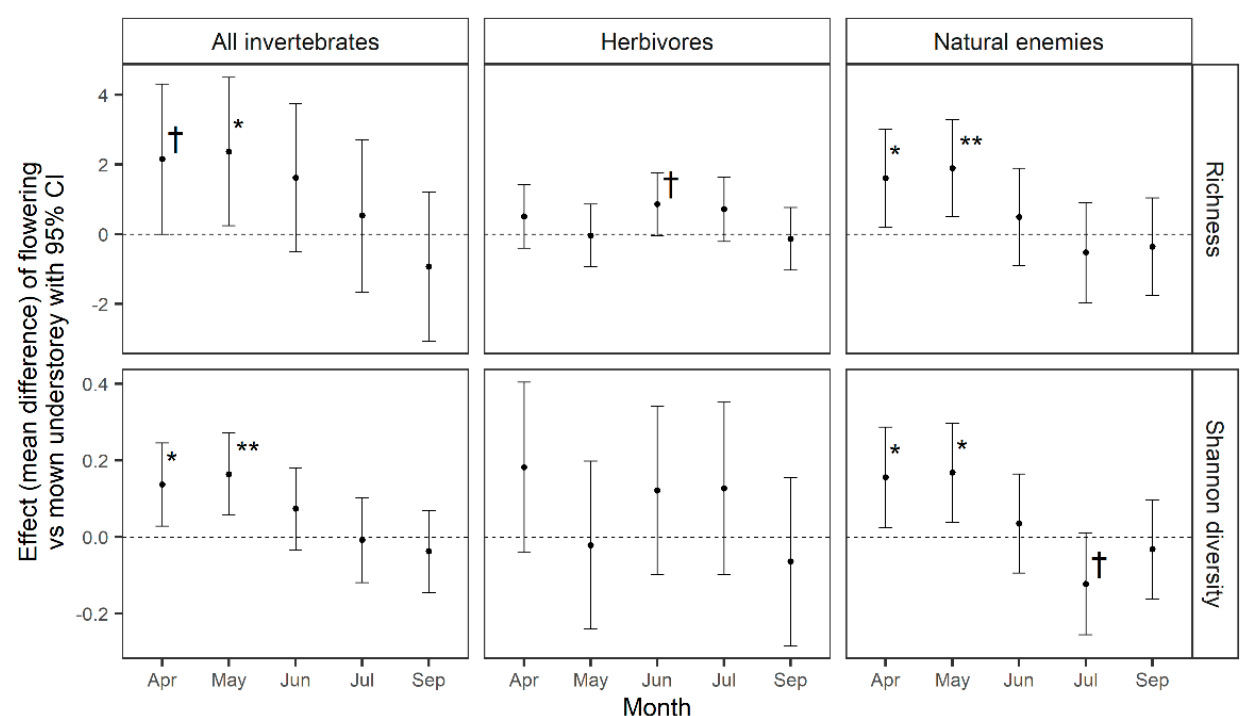
Figure 5. Effects of understorey management on invertebrate diversity and richness in pitfall traps. Effects are represented by mean difference between flowering and mown treatments, hence points above the dashed line (y = 0) represent higher richness/diversity in arable alleys adjacent to flowering than mown understoreys. Effect sizes and confidence intervals are based on the outputs of mixed models where richness or diversity of each trophic level was the response variable, and the interaction between treatment and month was the fixed effect, with block as a random effect. Symbols refer to p -values, where ** < 0.01, * < 0.05, † < 0.1. See Table S7 for model outputs.